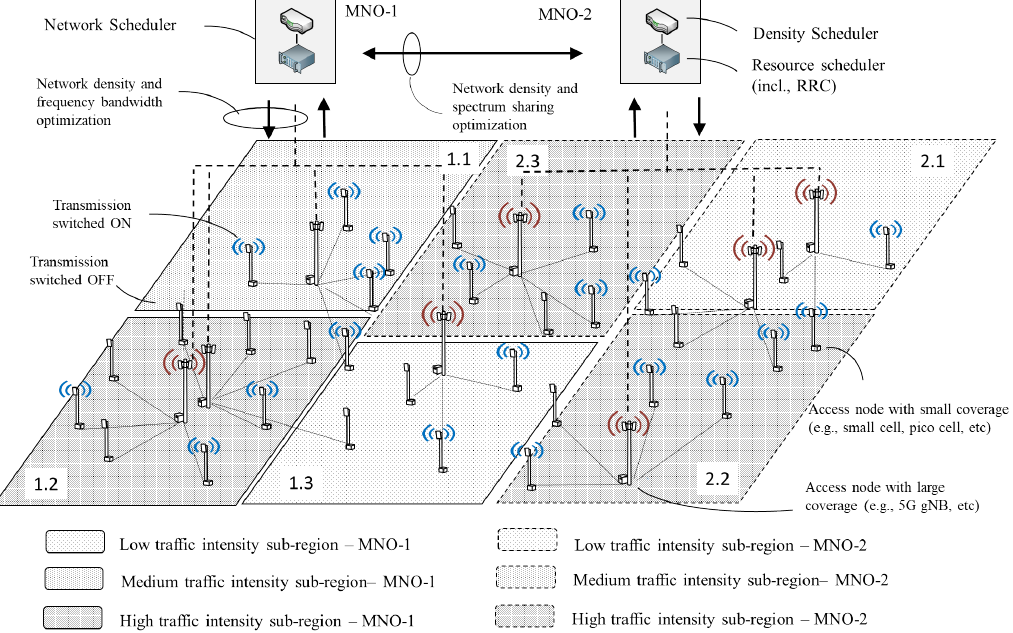
Figure 5. Example of joint optimization of scheduled network density and spectrum for multiple sub-regions of two different MNOs with different traffic conditions.